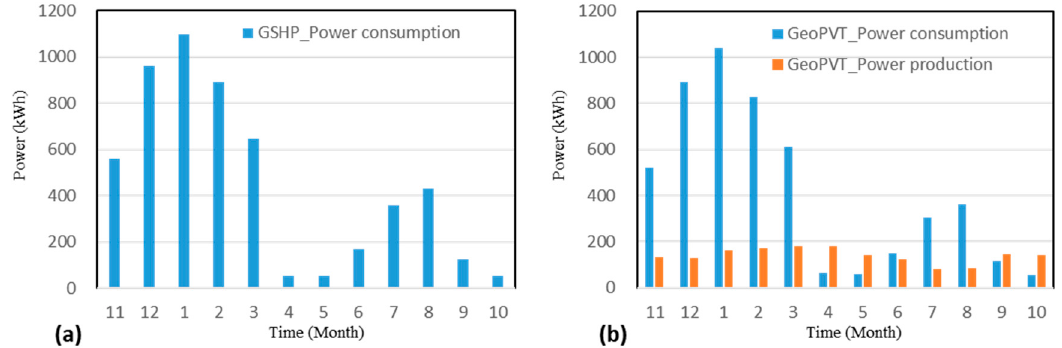
Figure 38. Power consumption and production of system in 99 m 2 . ( a ) GSHP; ( b ) Geo-PVT.